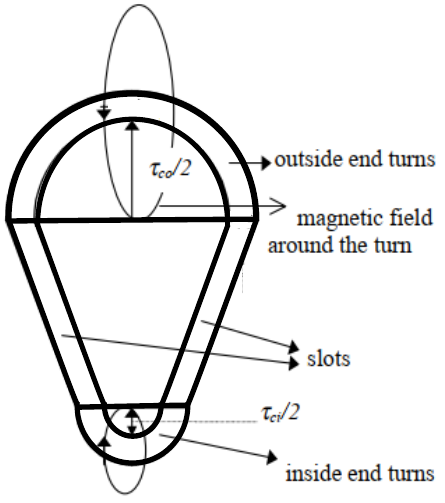
Figure 8. Geometry of a coil of the stator disk.